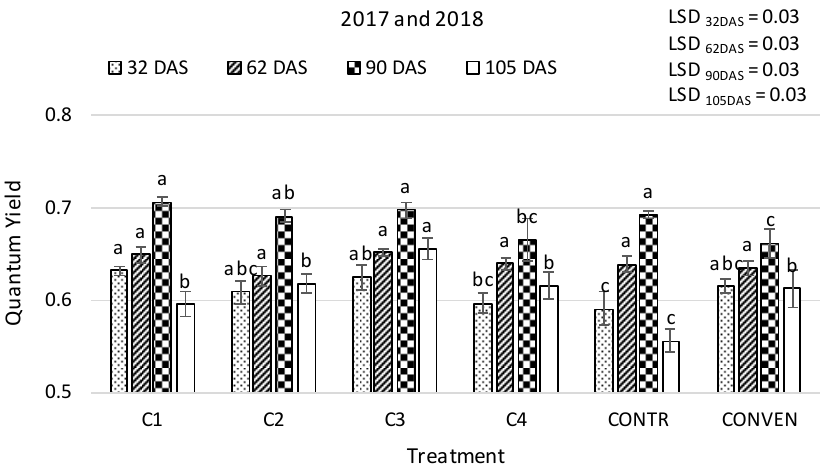
Figure 7. Quantum yield of rice plants (means ± se) grown in di ff erently fertilized soil at 32, 62, 90, and 105 days after the sowing (DAS) of the experiments during 2017 and 2018. Treatments contain compost application of (i) 80 kg ha − 1 N in split application (C1), (ii) 160 kg ha − 1 N in split application (C2), (iii) 320 kg ha − 1 N in split application (C3), (iv) 160 kg ha − 1 N in single application (C4), (v) an untreated control (CONTR), and (vi) 160 kg ha − 1 nitrogen chemical fertilizer (CONVEN). Means were compared by the Bonferroni adjusted LSD value at p < 0.05. Di ff erent letters characterize significant di ff erences between treatments for each DAS. Full description of the treatments examined is given